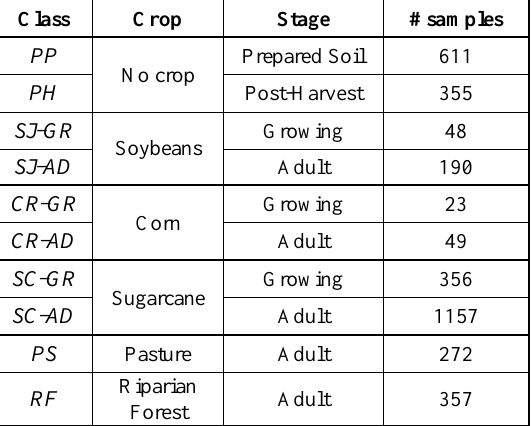
Table 2: Classes considered in the Markov model and their relation to crop types and phenological stages.